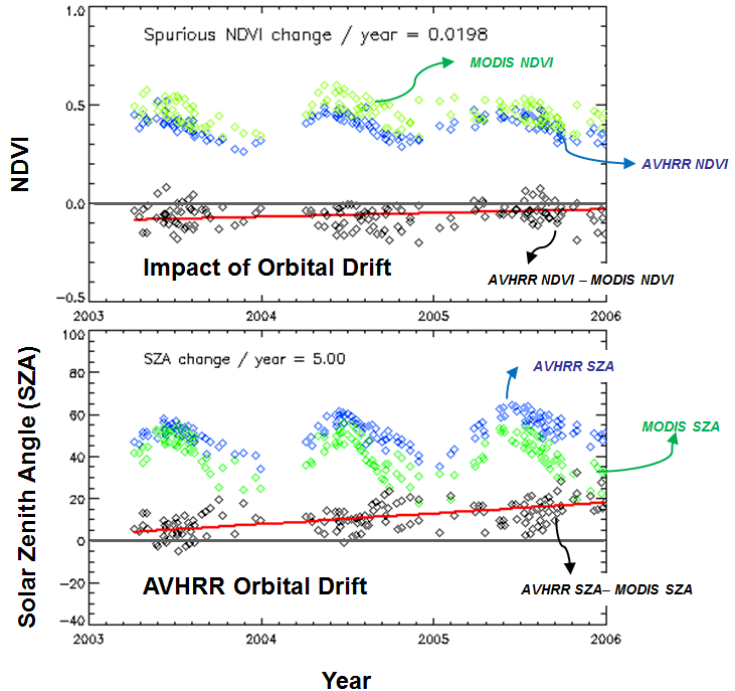
Figure 1. Demonstration of estimation of orbital drift related spurious inter-annual trends in Advanced Very High Resolution Radiometer (AVHRR) Normalized Difference Vegetation Index (NDVI) data. The green, blue, and black colored data represent MODerate resolution Imaging Spectrometer (MODIS) Aqua NDVI data, AVHRR NDVI data, and the difference between these two data (AVHRR NDVI—MODIS NDVI) respectively. The thick red line represents the spurious inter-annual trend. The magnitude of the spurious NDVI trend was determined by estimating slope of the linear curve fitted to the Long Term Data Record (LTDR) AVHRR NDVI and MODIS-Aqua data differences. The inter-annual SZA change is also estimated by similar comparison with MODIS